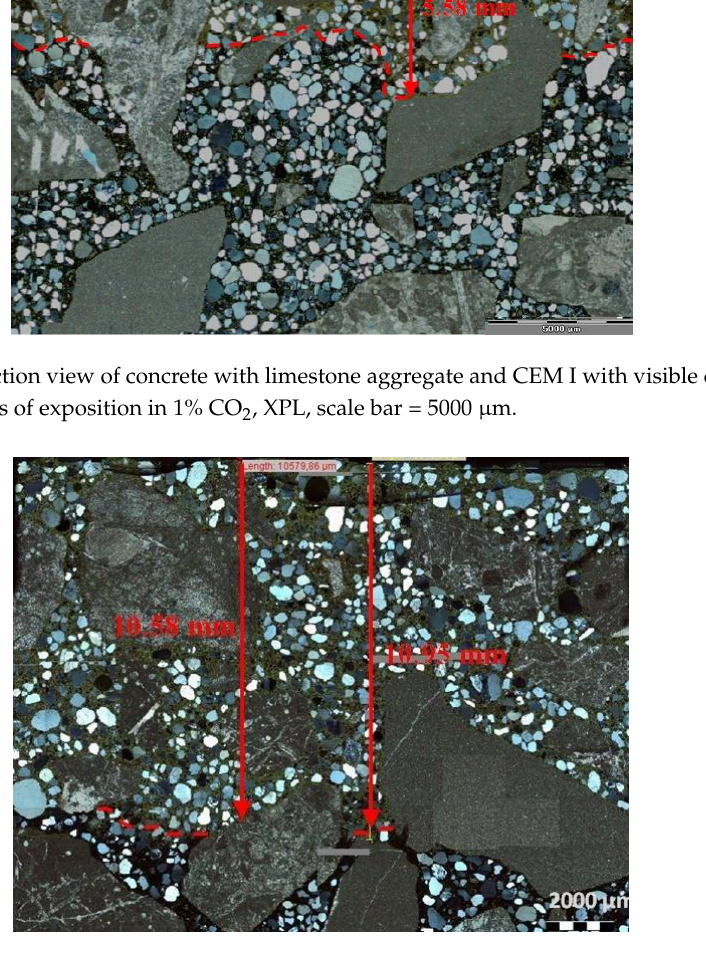
Figure 7. Thin-section view of concrete with limestone aggregate and CEM II/B-M (V–W) with visible carbonation front, after 56 days of exposition in 1% CO 2 , XPL, scale bar = 2000 µm.